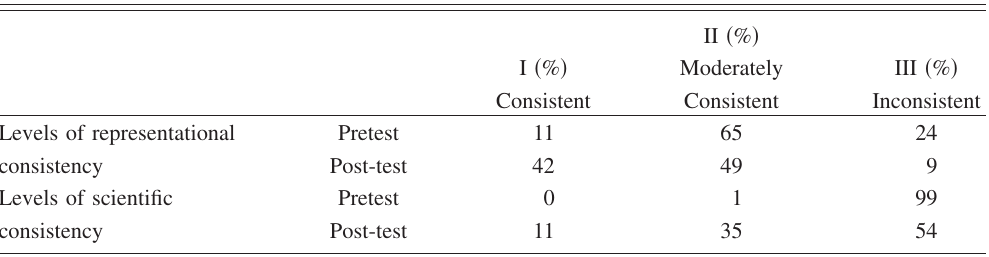
TABLE II. Levels of representational and scientific consistency (cid:1) n =168 (cid:2) .